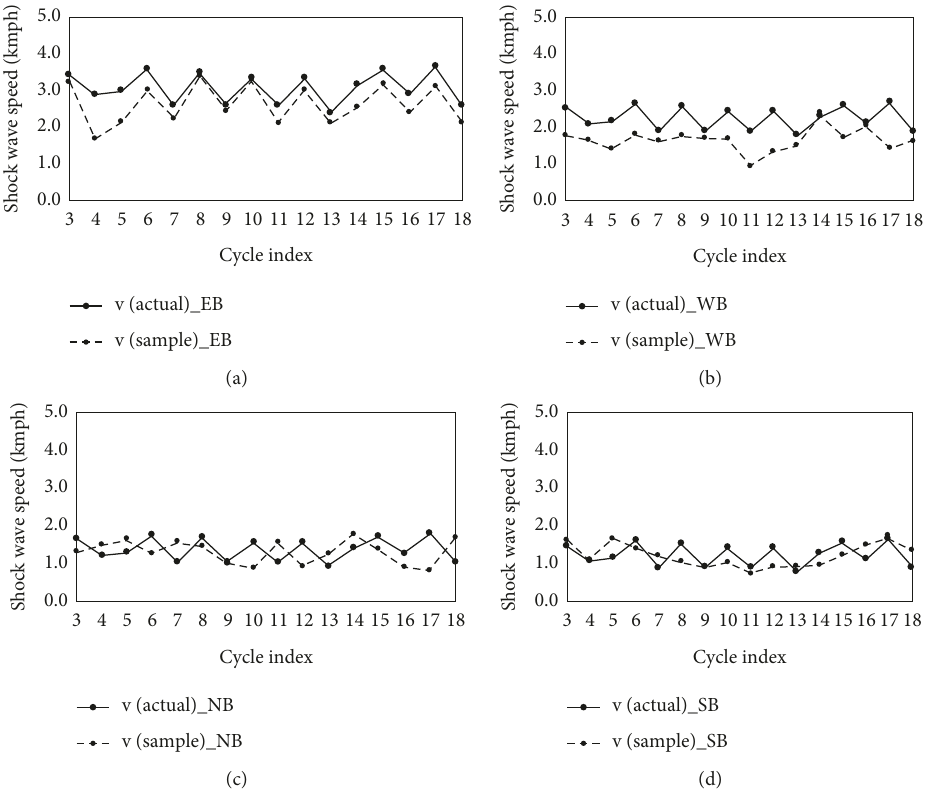
Figure 6: Variation of actual and predicted shock wave speed values across cycles. (a) EB phase, (b) WB phase, (c) NB phase, and (d) SB phase.